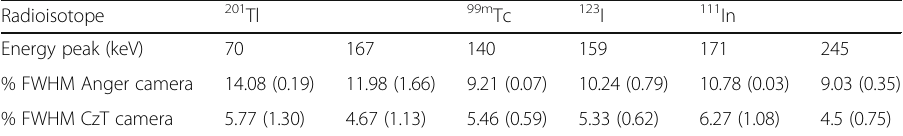
Table 1 Percent FWHM measured on CzT and Anger cameras for 6 energy peaks. Results are expressed in mean (SD)